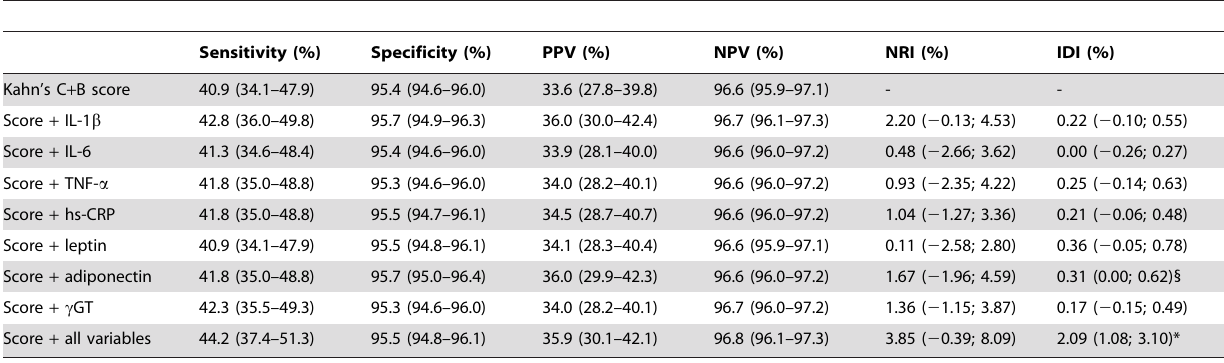
Table 4. Impact of adding different adipocytokine, hepatic or inflammatory markers as quartiles in the ability of a clinical + biological risk score to predict type 2 diabetes, using a 23% probability threshold to define high risk